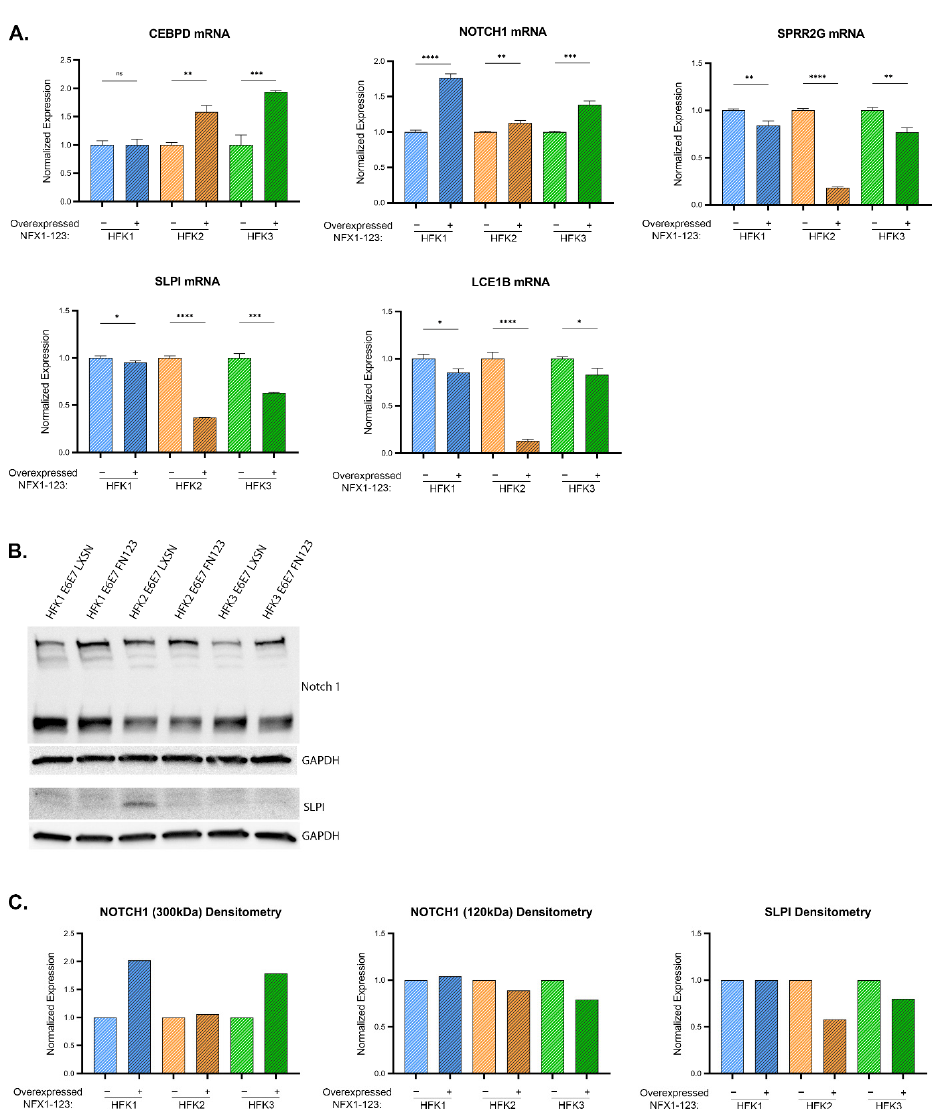
Figure 7. Influence of NFX1 expression on LASSO-identified gene expression. ( A ) CEBPD, SPRR2G, NOTCH1, LCE1B, and SLPI transcript levels (determined by qPCR) in HFK1-3 with and without exogenous NFX1-123 expression. Samples are normalized to a housekeeping gene (36B4 or GAPDH) and HFKs are normalized to their LXSN vector control for each pair. Error bars represent standard deviation for technical replicates ( n = 3). Asterisks denote significant differences between HFK cells with and without exogenous NFX1-123 expression as determined by Student t -Test. p value: * = 0.03; ** = 0.002; *** = 0.0002; **** ≤ 0.0001. ( B ) Representative immunoblots of NOTCH1 (top) and SLPI (bottom) are shown. GAPDH is included as a loading control. ( C ) Densitometry of shown immunoblots (NOTCH1 and SLPI) normalized to GAPDH abundance and similarly to qPCR to each HFK LXSN vector control. Two distinct bands were detected for NOTCH1.